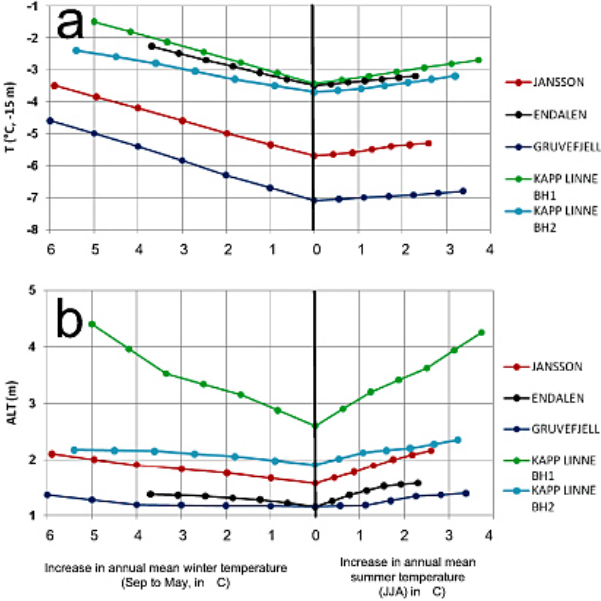
Fig. 7. Impact of GST changes during summer (JJA) and fall/winter/spring (September to May) on ground temperature in 15m depth (a) and on ALT (b) for the different study sites. The model was then run over a period of 10years and the presented re- sults are the differences to the undisturbed